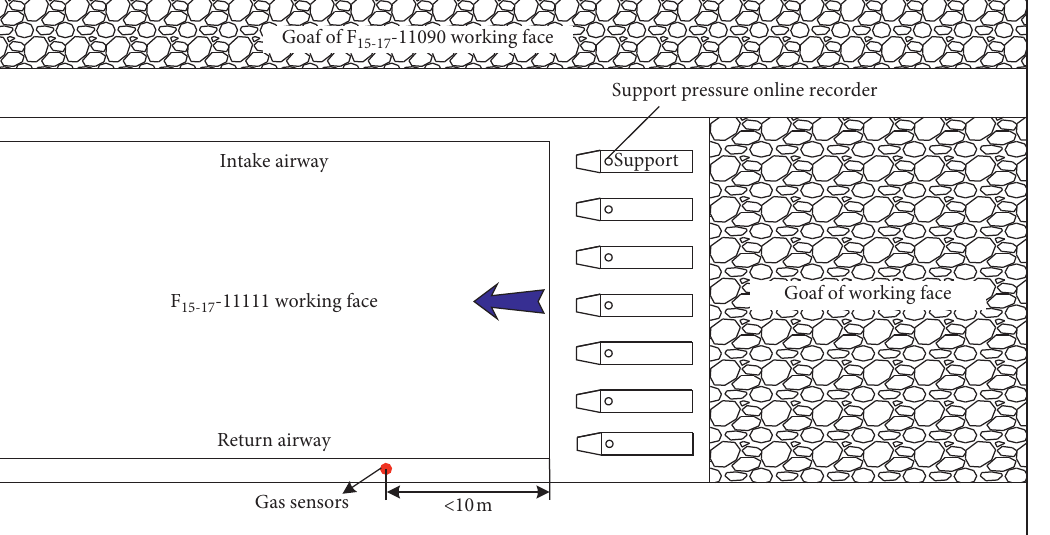
Figure 6: Schematic diagram of gas and stress monitoring design in the working